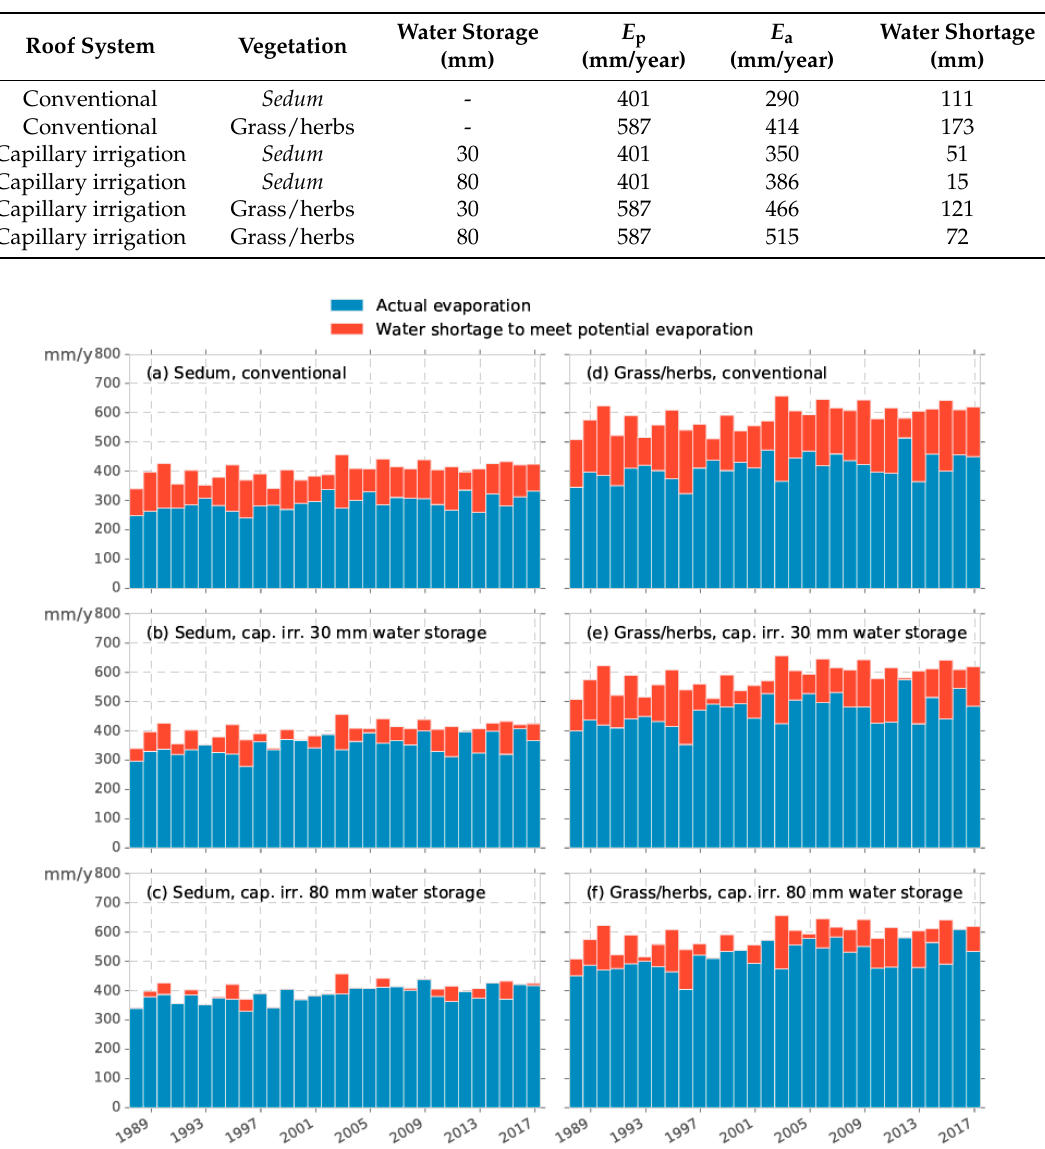
Figure 8. Simulated long-term yearly evaporation and water shortage (difference between E p and E a ) of six different green roof setups.